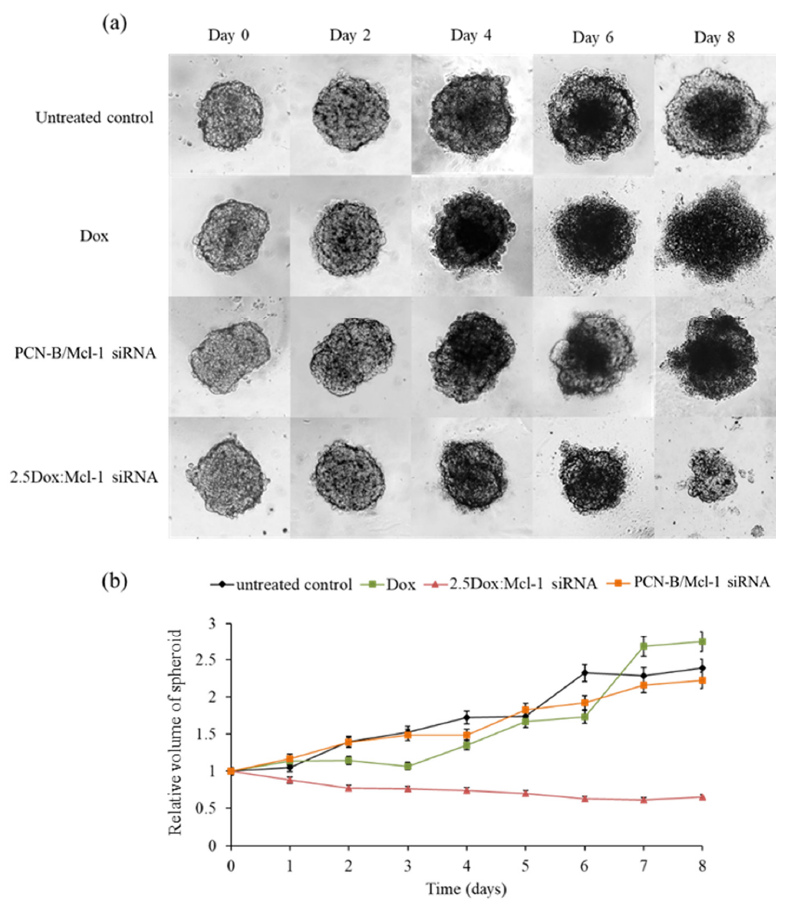
Figure 9. Synergistic effect on the growth of MCF-7 3D spheroid cells ( a ) spheroid images under a microscope at various time points and ( b ) relative volume of spheroids from day 0 -day 8 . The Dox and Mcl-1 siRNA concentration were used at 1.25 and 0.5 µM, respectively, for the individual treatments and the combination.